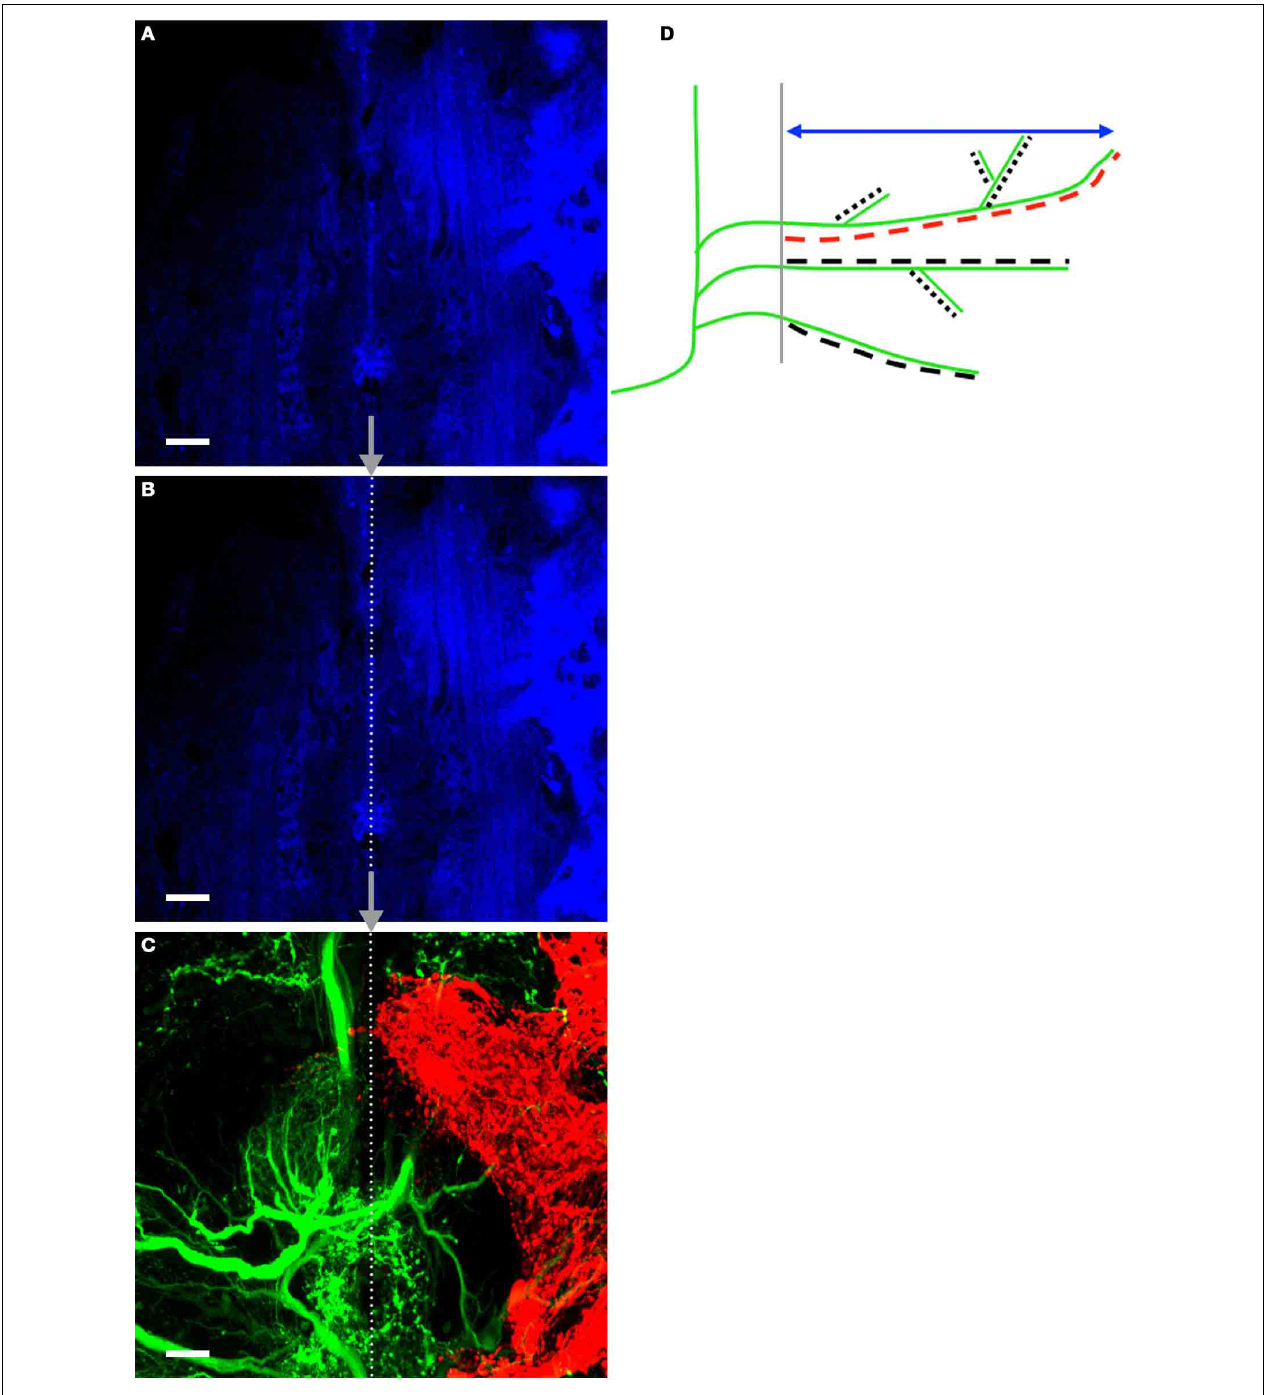
line. Scale bars = 20 µ m. A schematic highlighting the measurements made in this study is shown in (D) . AN dendrites crossing the midline (gray) are represented in the schematic in green. The double-headed arrow (blue) indicates the perpendicular extent measurement. The longest dendrite length was recorded for each animal and is highlighted here in red. All dendrites and their branches were hand-traced (represented by the dashed lines), and the skeletal length measurement is the sum of the lengths of the dashed lines. For simplicity AN dendrites only are represented here but the same methods were used to measure N5 axonal growth across the